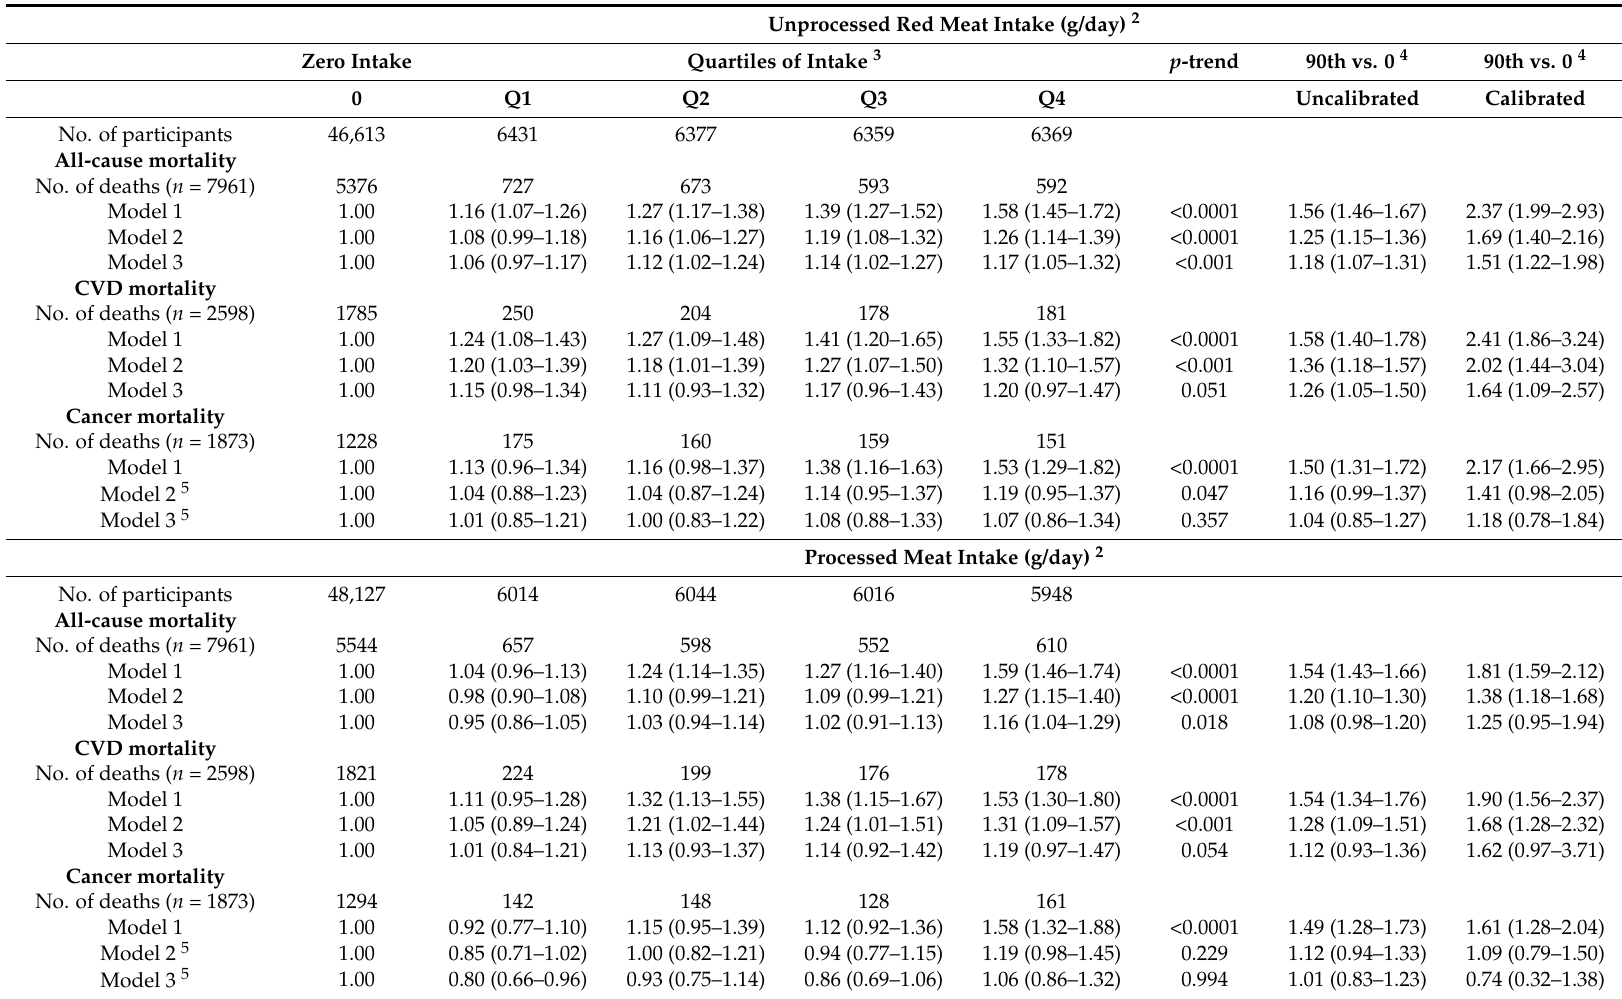
Table 2. The association between red meat and processed meat intake and all-cause, cardiovascular, and cancer mortality in the AHS-2 cohort ( N = 72,149) 1